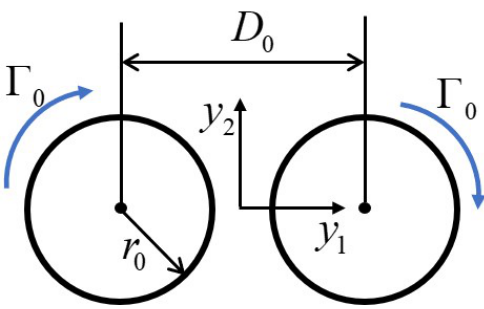
Figure 9. Schematic of the co-rotating vortex pair.